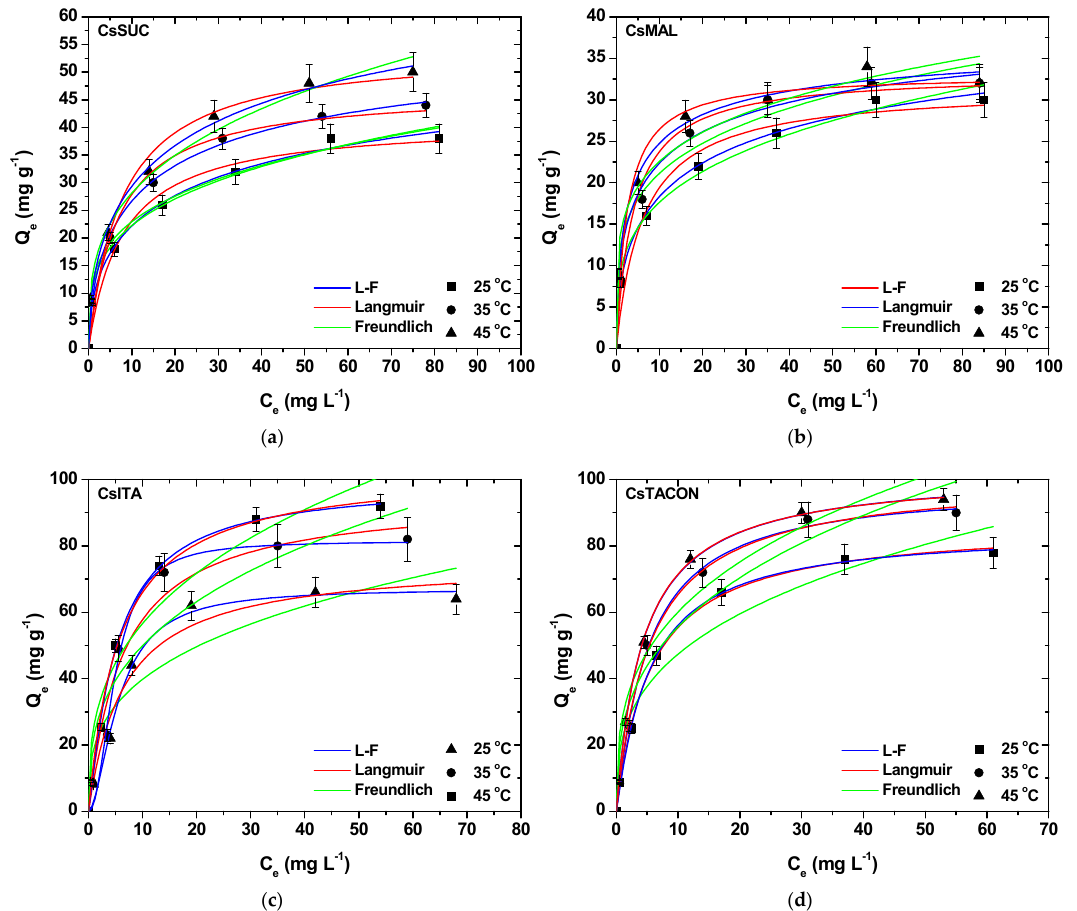
Figure 8. Isotherms for the removal of DCF by ( a ) CsSUC; ( b ) CsMAL; ( c ) CsITA; ( d )